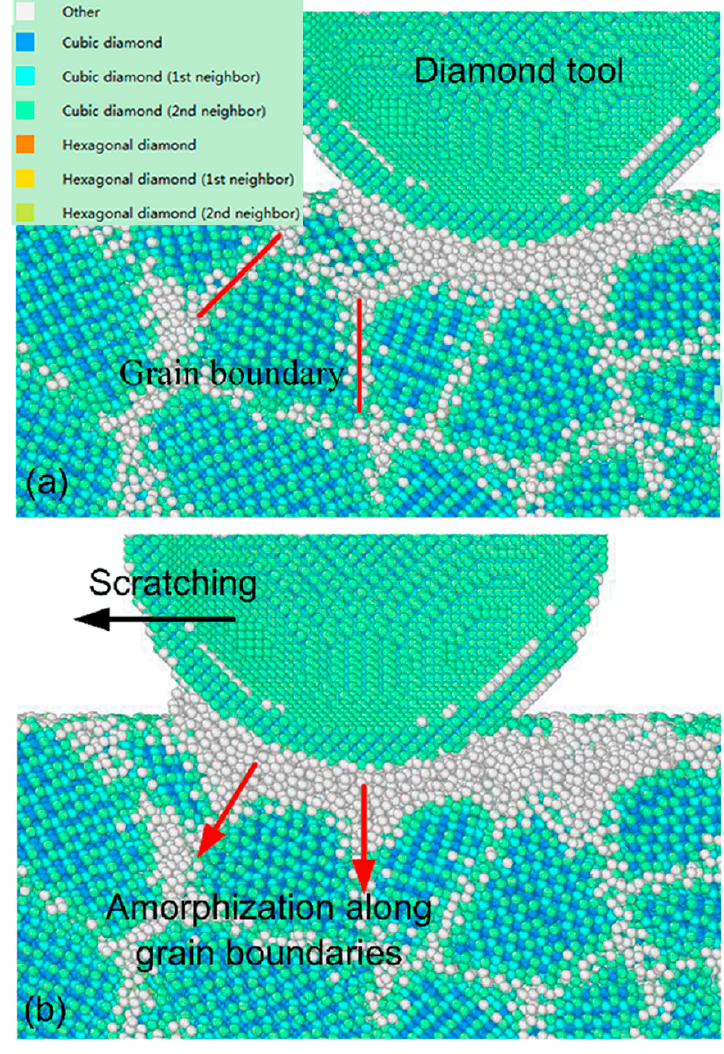
Figure 5. Deformation behavior of a polycrystalline silicon ( a ) and the amorphization of silicon along the grain boundary ( b ). Here the average substrate grain size is 4 nm. The scratching depth is 1 nm. Atoms are colored using theIdentify diamond structure module in OVITO.